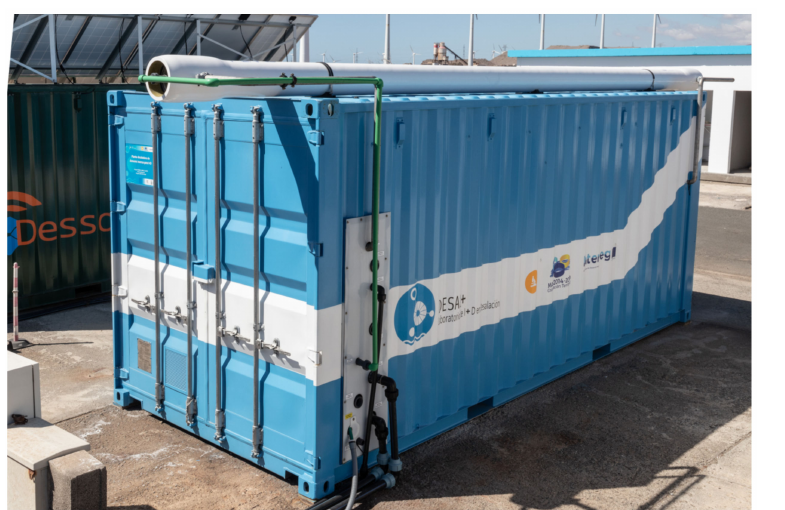
Figure 1. Desalination plant diagram.